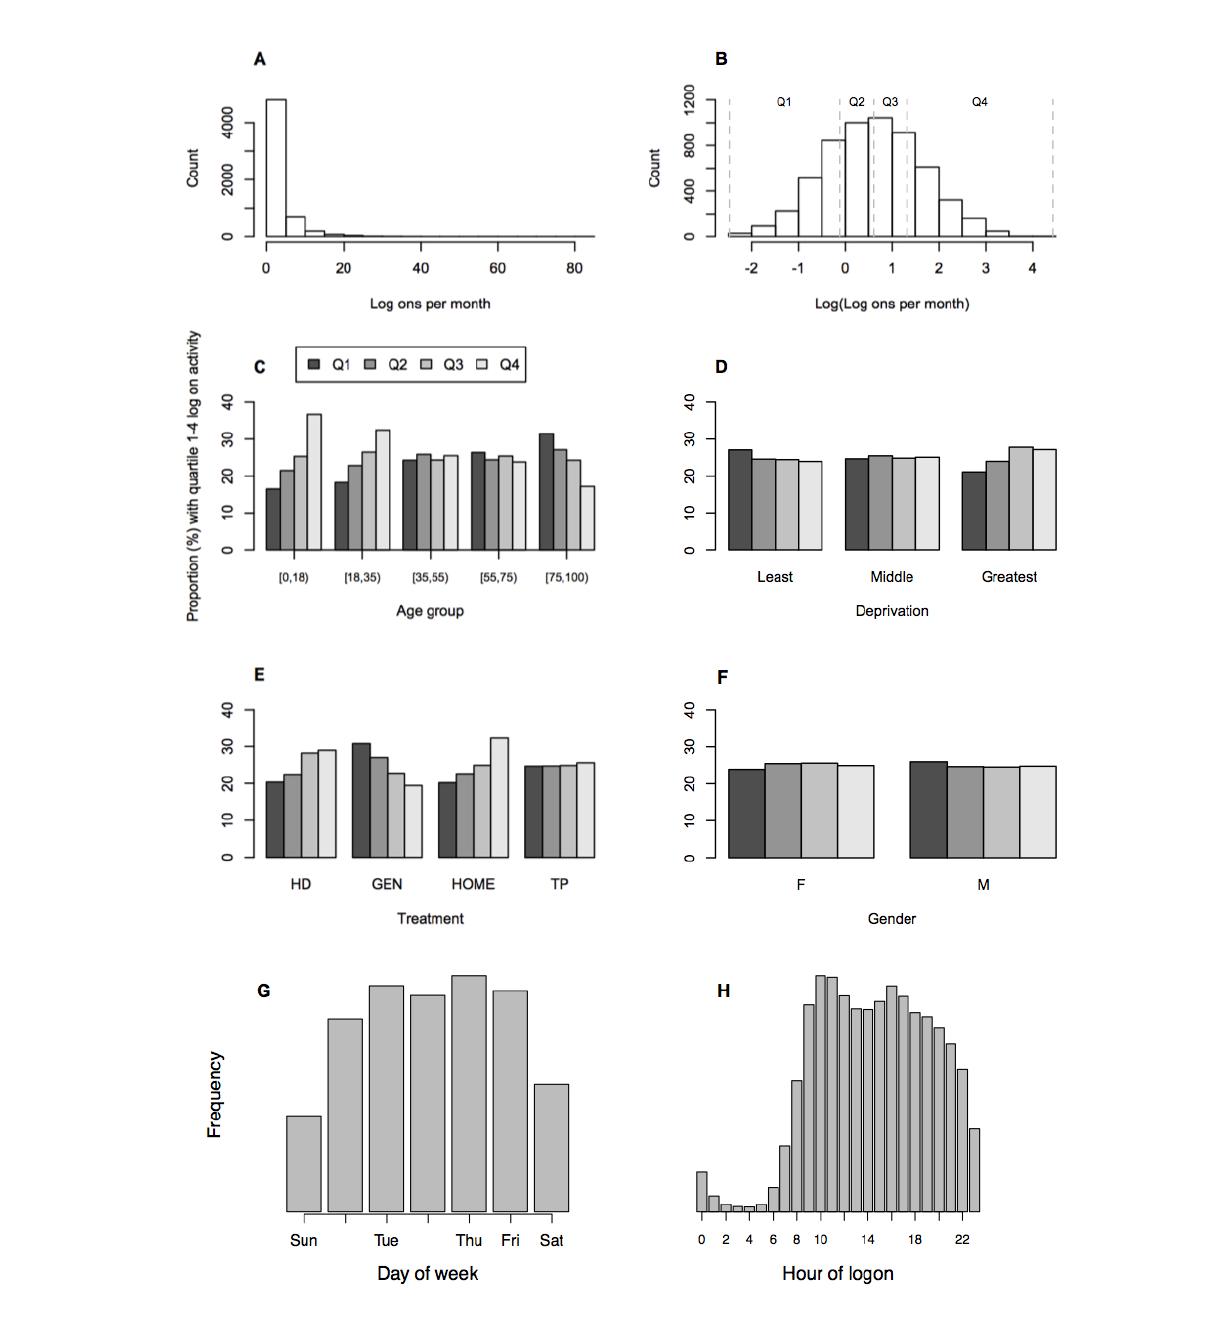
Figure 6. Logon activity. A-F: Patients classified by quartile of log (count of logons per month) (defined in panels A and B as described in the Methods), and comparisons made of the partitioning of Q1-Q4 activity patients by the factors shown. The even spread by gender contrasts with that by age (C) and treatment type (E). G-H: Histograms of counts of logons made by day of week (G) and time of day